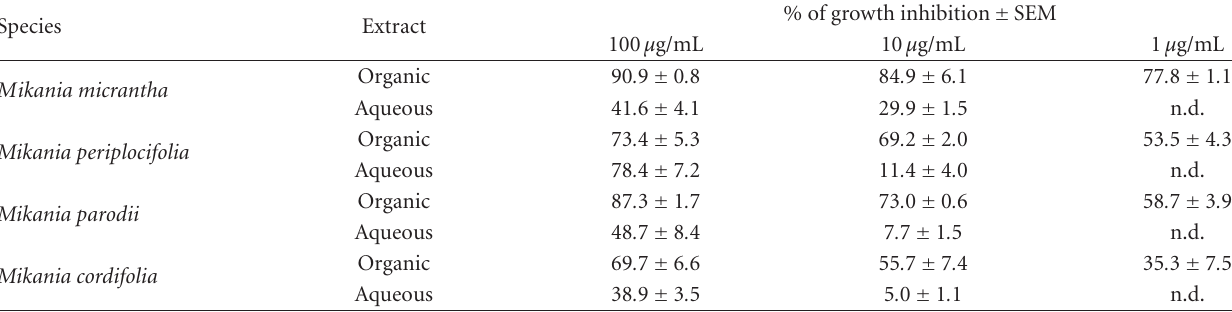
Table 2: Leishmanicidal activity of organic and aqueous extracts of Mikania micrantha , M. periplocifolia , M. parodii, and M. cordifolia. Species